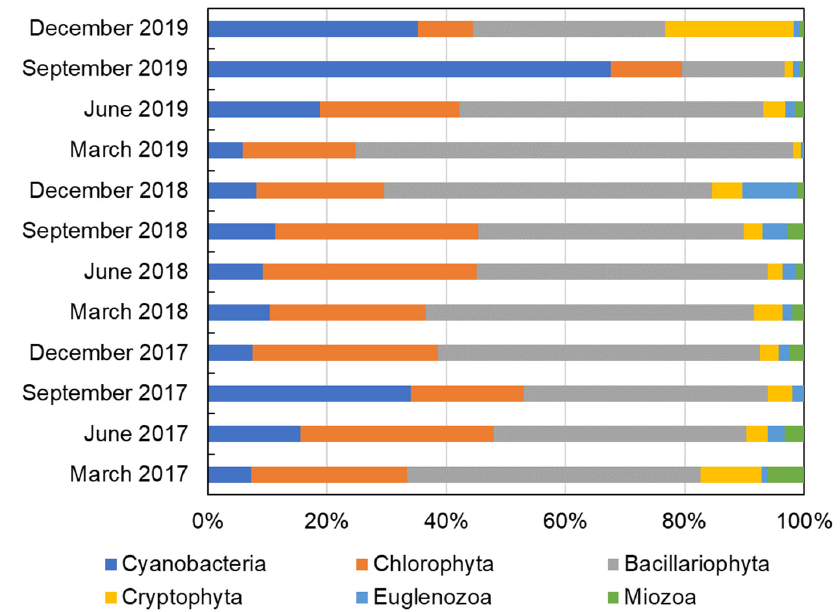
Figure 3. Interannual variation of phytoplankton composition in Dongting Lake.